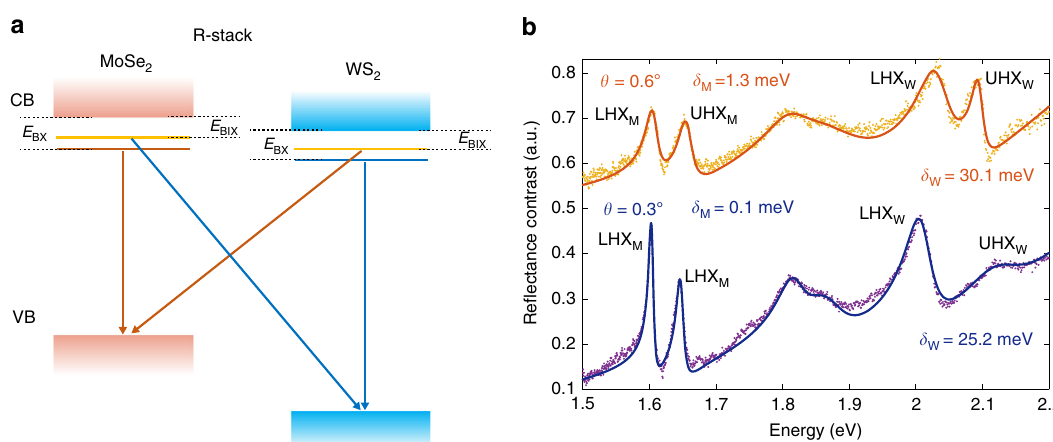
Fig. 4 Comparison of MoA and WA hybrid states. a Band diagram of R-stacking MoSe 2 /WS 2 bilayers. The conduction and valence bands are represented by broad continuous bands. Exciton states are represented by the horizontal solid lines. Arrows represent spin-conserved exciton transitions, which are lowered in energy from the band-to-band transition by binding energy. E BX and E BIX denote the binding energies for the intra- and interlayer transitions, respectively. b RC spectra of both MoA and WA hybrid excitons from bilayers with θ ~ 0°. Dots are the data, and solid lines are fi ts. The corresponding θ and detuning δ M and δ W obtained from fi tting are labeled by each